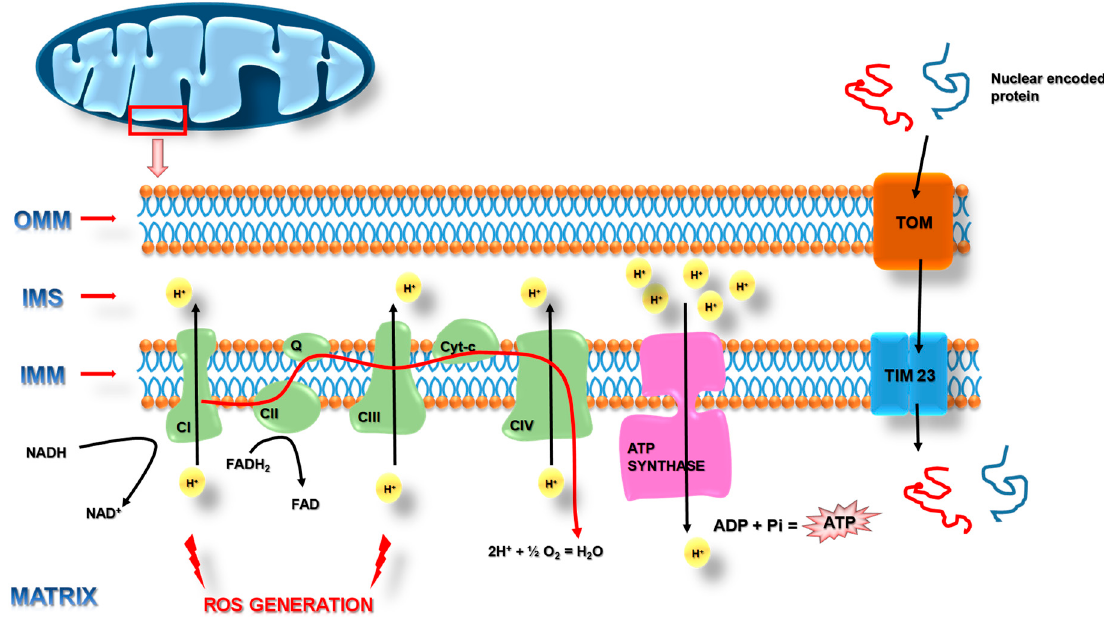
Figure 1. Mitochondrial electron transport chain and reactive oxygen species generation places. CI—Complex I (NADH dehydrogenase); CII—Complex II (succinate dehydrogenase); Q—Quinone; CIII—Complex III (cytochrome bc1 complex); cyt-c—cytochrome c; CIV—Complex IV (cytochrome c oxidase); OMM (outer mitochondria membrane); IMS (intermem- brane space); IMM (inter mitochondrial membrane); TOM (translocase of the outer mitochondrial membrane); TIM 23 (translocase of the inner mitochondrial membrane 23). Details in the text.